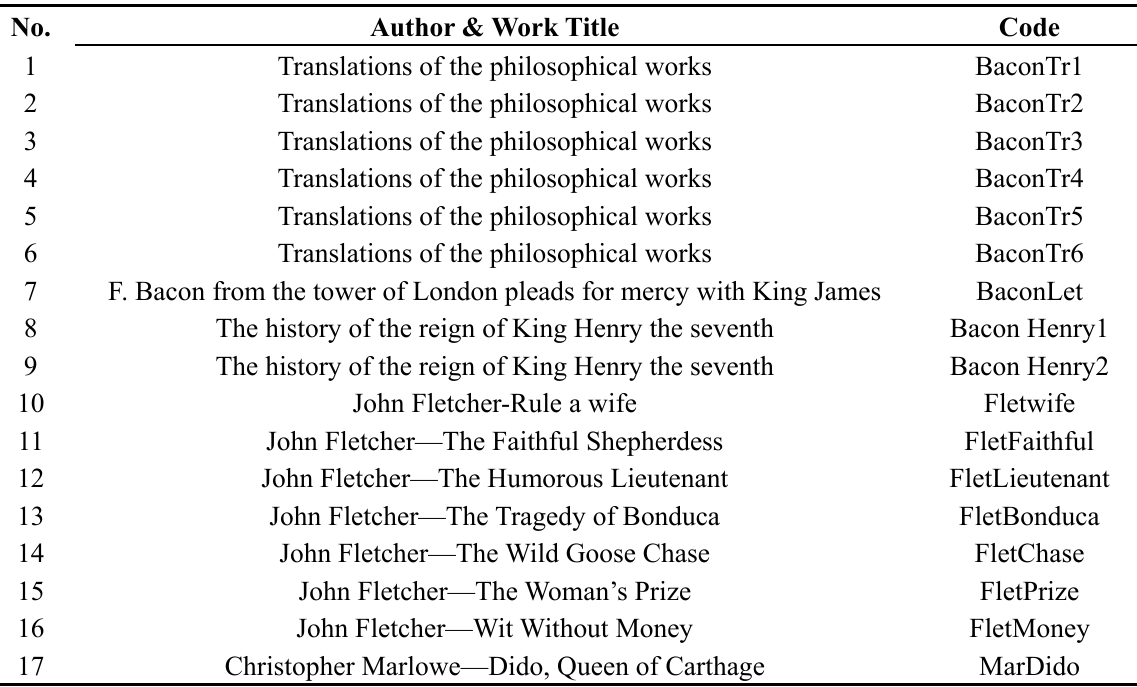
Table 1. Forty-two digital electronic